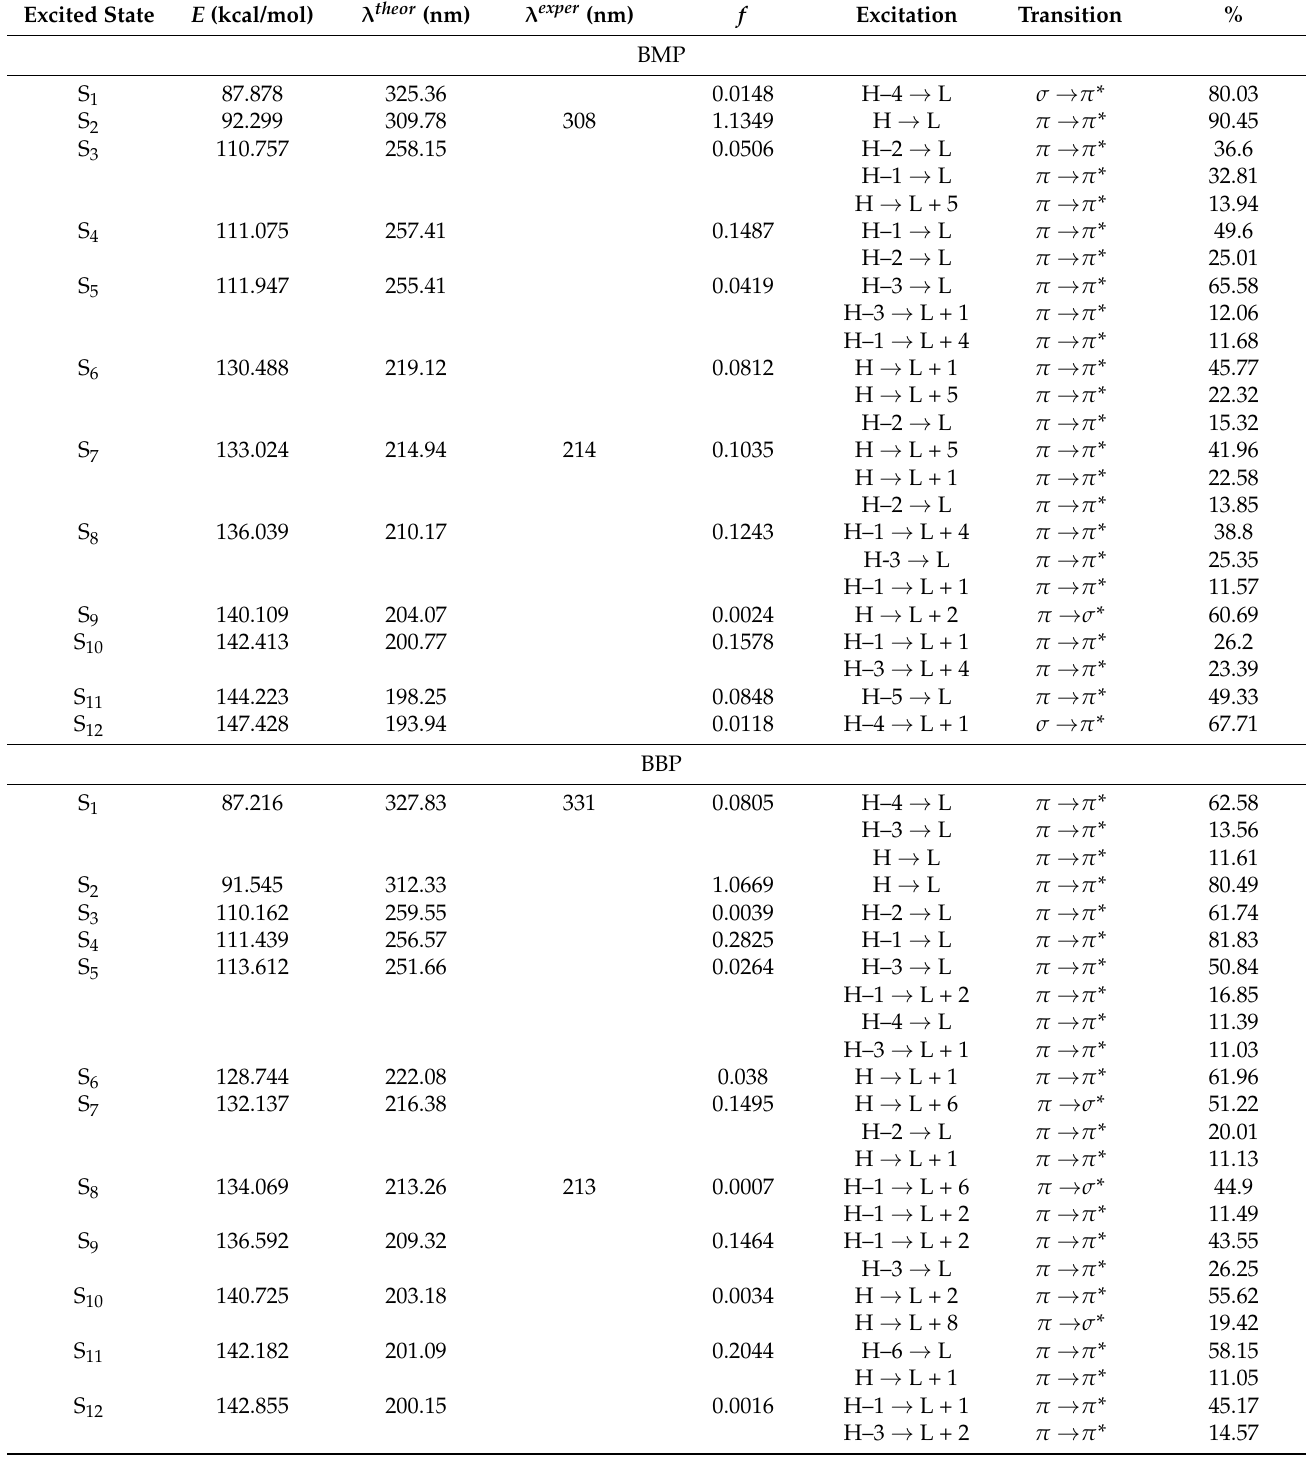
Table 4. Vertical excitation energies ( E ), absorption wavelength ( λ ), oscillator strength ( f ) and the corresponding electronic transition of the twelve excited states of BMP and BBP calculated